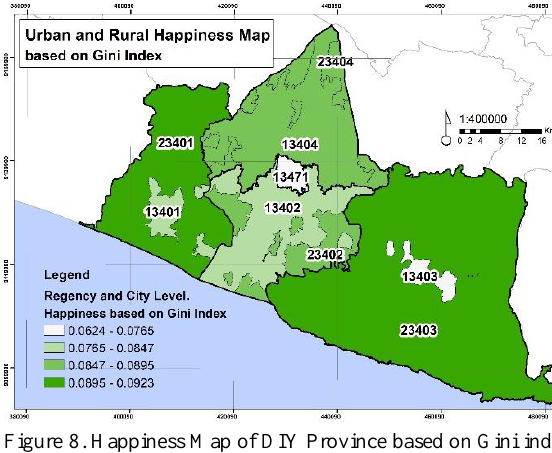
Figure 8. Happiness Map of DIY Province based on Gini index